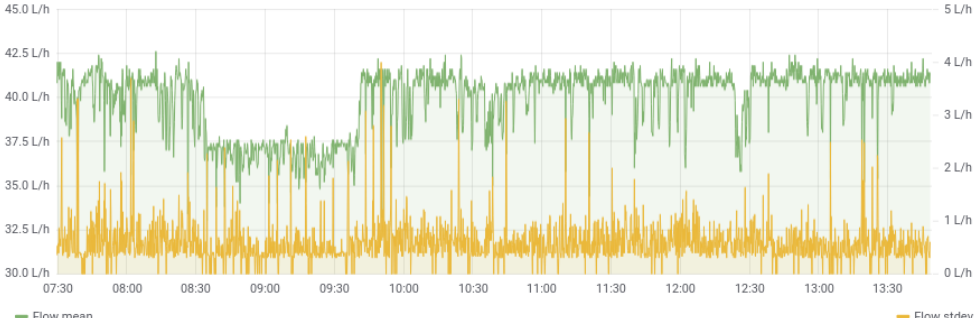
Figure 11. Mean mass flow rate (left Y-axis) and standard deviation (right Y-axis).